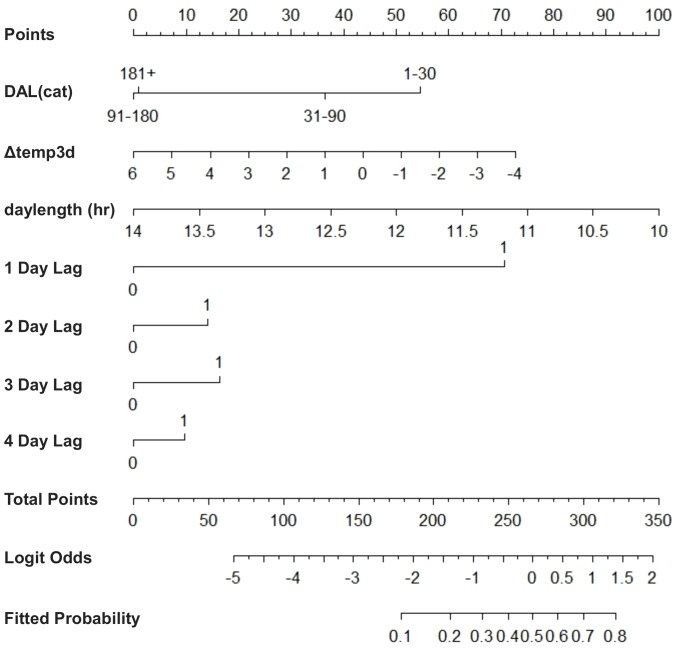
Nomogram depicting effect sizes for the best supported lemon shark residency model.To use the nomogram, locate the desired level of each variable and follow the position vertically up to the Points Scale. Repeat this for all variables and add up the points, then find that value on the Total Points Scale. Finally follow that position directly down to the Fitted Probability Scale which gives the predicted probability of daily detection.